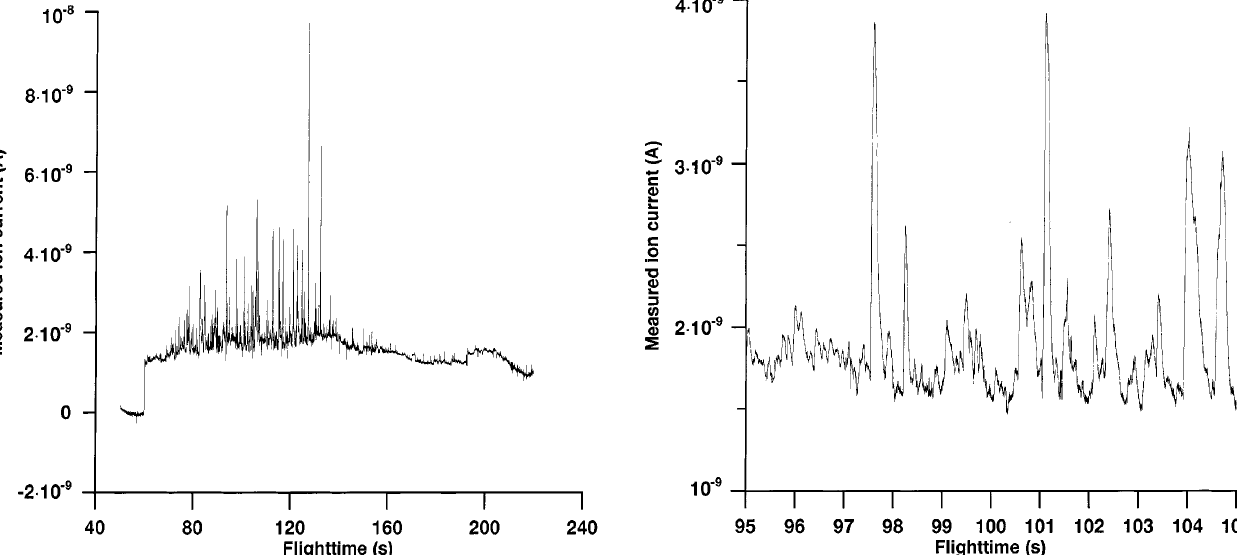
Fig. 3. The ion current observed by PIP during the flight from 50 to 220 s. The apogee was reached at 130.5 s